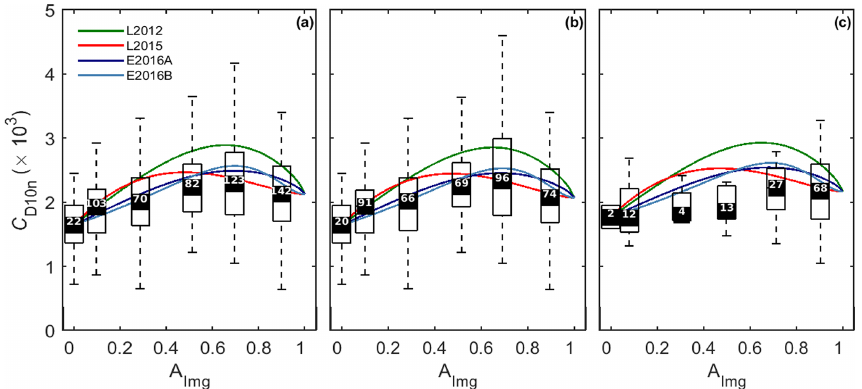
Figure 6. C D10n as a function of ice fraction, as derived from local imagery ( A Img ) for (a) the joint ACSE and AO2016 datasets ( n = 542), (b) the ACSE dataset ( n = 416) and (c) the AO2016 dataset ( n = 126). The boxes show the interquartile range and the bin median (black squares) for bins of width = 0.2 and plotted at the mean ice fraction for the bin; the number of data points in each bin is noted at the median level. Whiskers indicate the range of the estimates, excluding any outliers, which are plotted individually if present. Parameterization schemes are overlain as indicated, with each curve anchored at the observed median values of C D10nw ( A Img = 0) and C D10ni (defined here as A Img > 0.8) for each dataset.